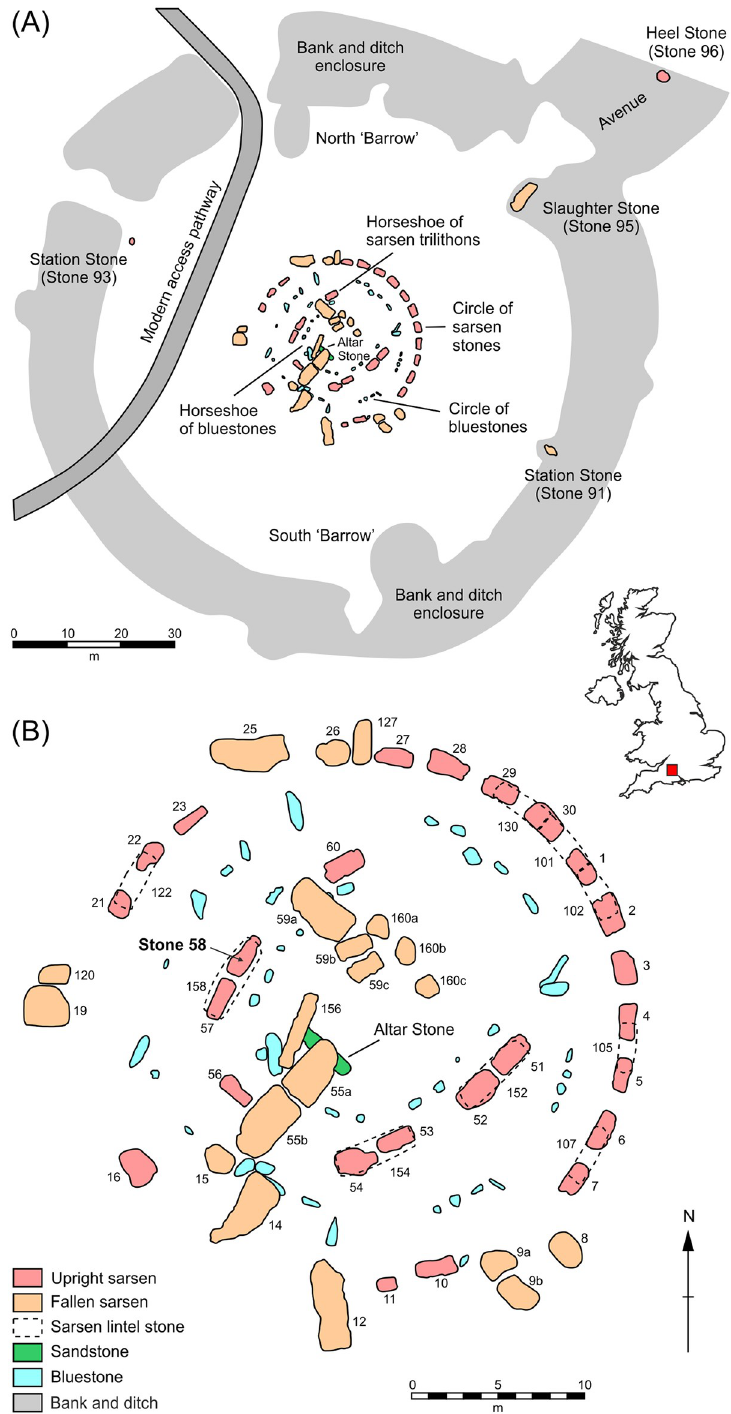
Fig 1. Plans of Stonehenge showing (A) the area of the monument enclosed by earthworks and (B) detail of the stone circle. Sarsen stones are numbered following the system devised by W.M. Flinders Petrie in the late 19th century